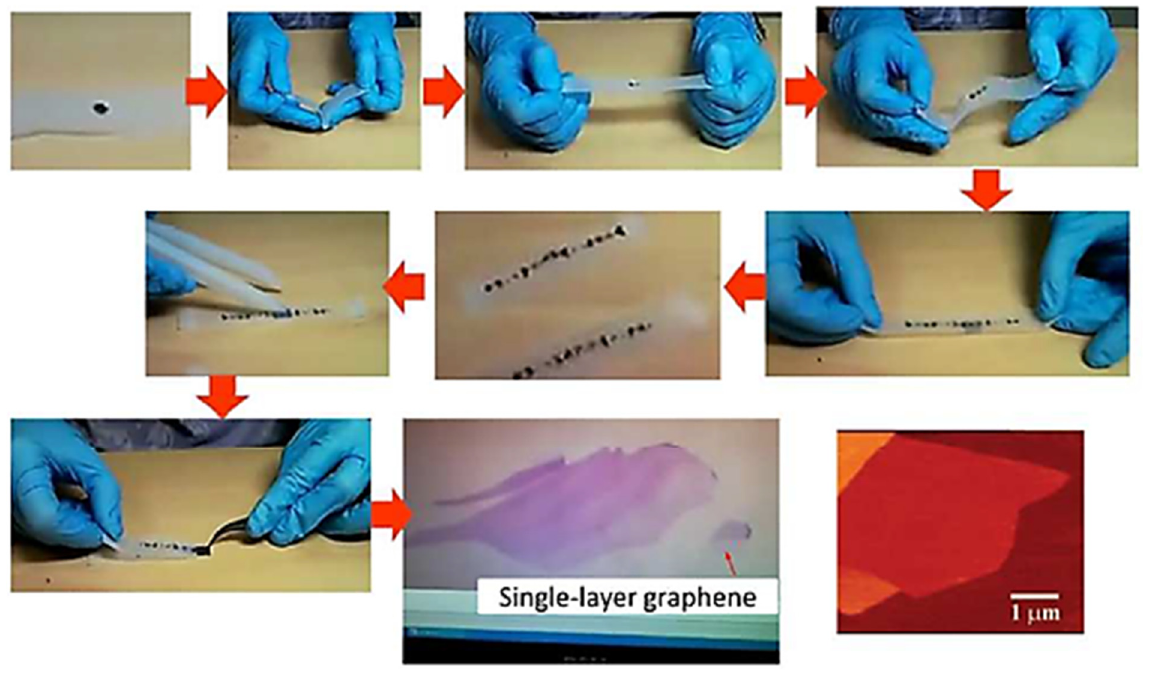
Figure 6. Illustration of ‘Scotch tape’ method to synthesize graphene. Adopted with permission from [67].